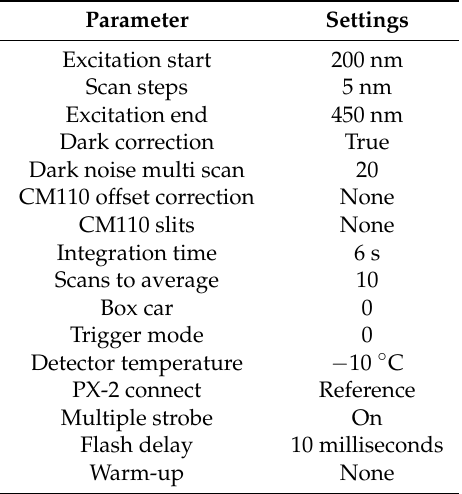
Table A2. EEMS measurement parameters for intensity calibration